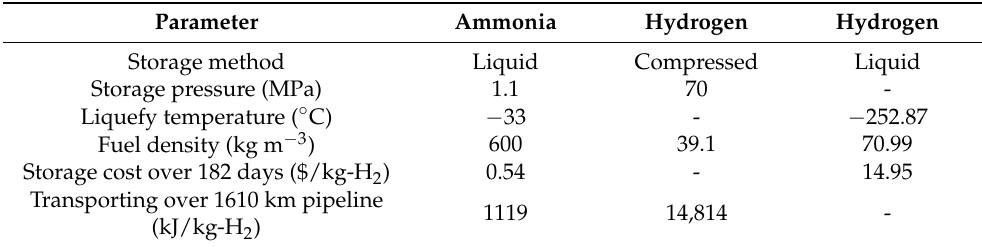
Table 3. Difference between NH 3 and H 2 in terms of storage and distribution